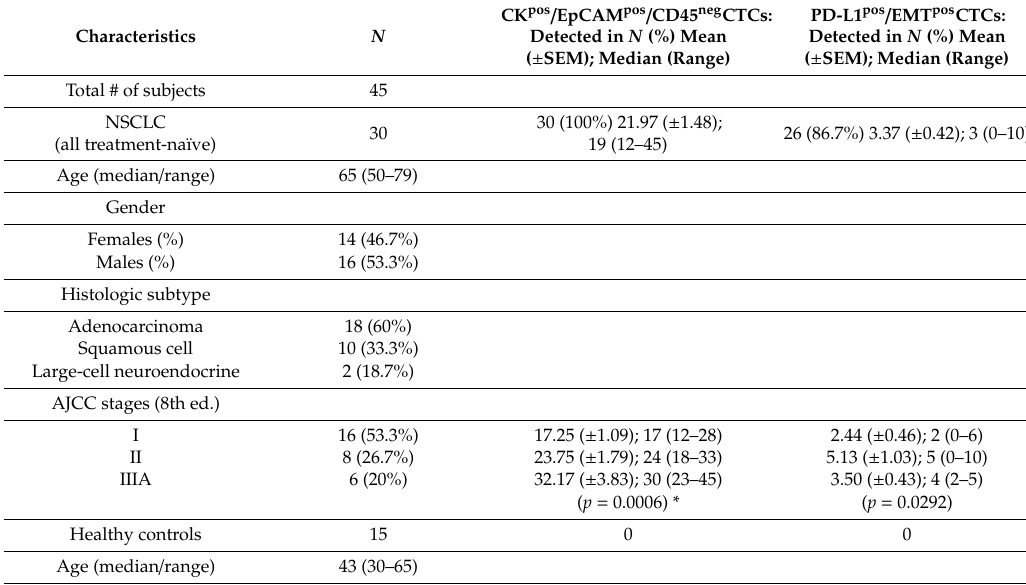
Table 1. Subjects’ characteristics and analysis for circulating tumor cells (CTCs).